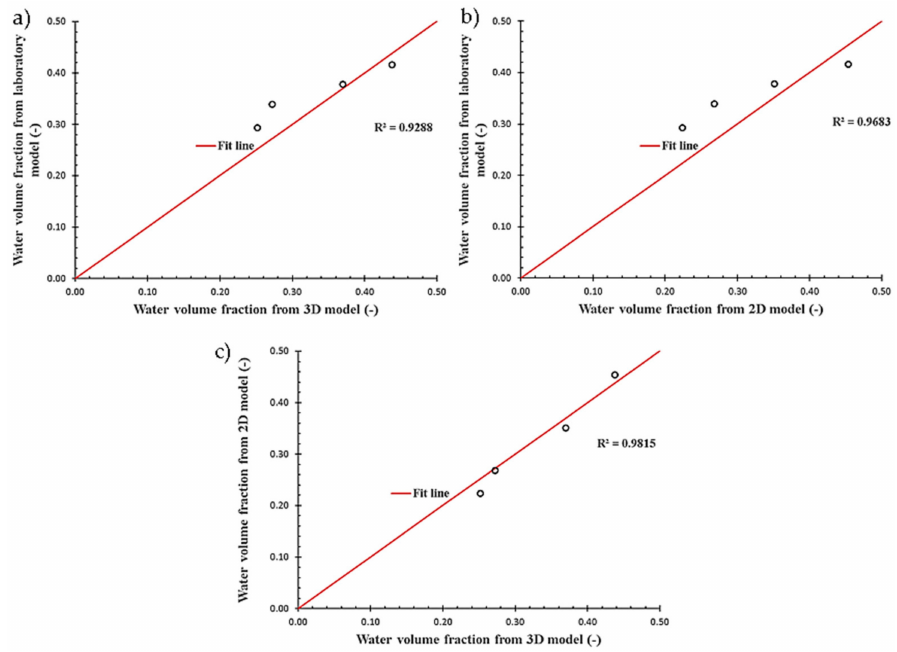
Figure 9. Comparison of modelling results with measurement results: ( a ) 3D model vs. measurements, ( b ) 2D model vs. measurements, ( c ) 3D model vs. 2D